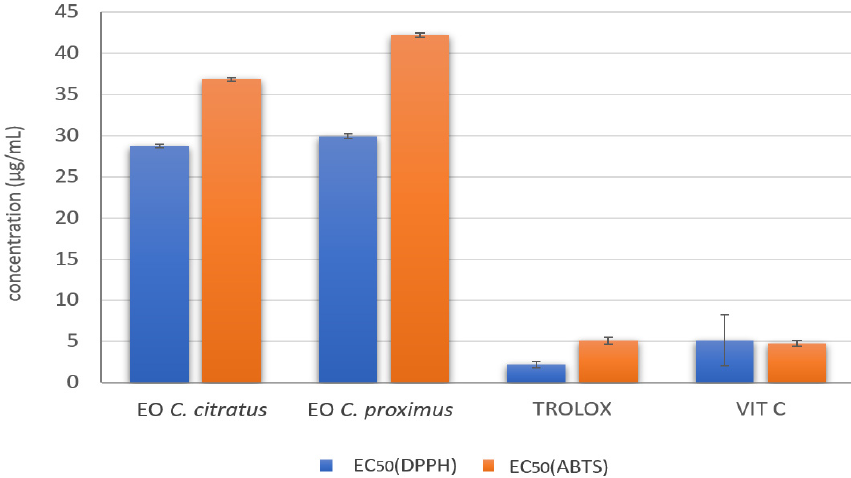
Figure 4. Radical scavenging activity against 2,2-Diphenyl-1-(2,4,6-trinitrophenyl) hydrazy (DPPH) and 2, 2 ′ -Azino-Bis-3-Ethylbenzothiazoline-6-Sulfonic Acid (ABTS) of the C. citratus and C. proximus EOs.